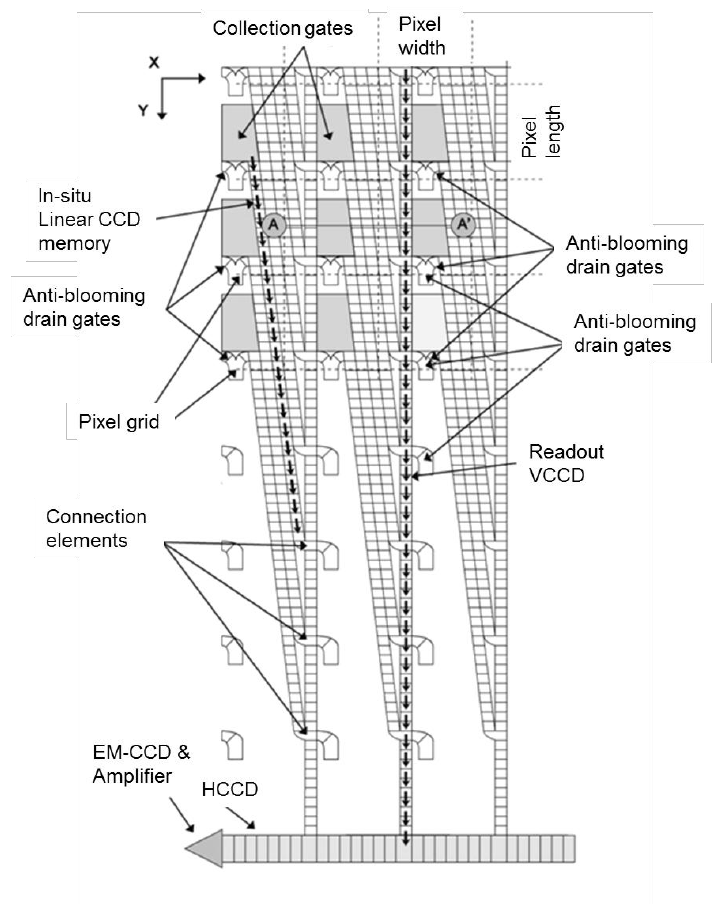
Figure 1. Plane structure of ISIS with slanted linear storage CCDs